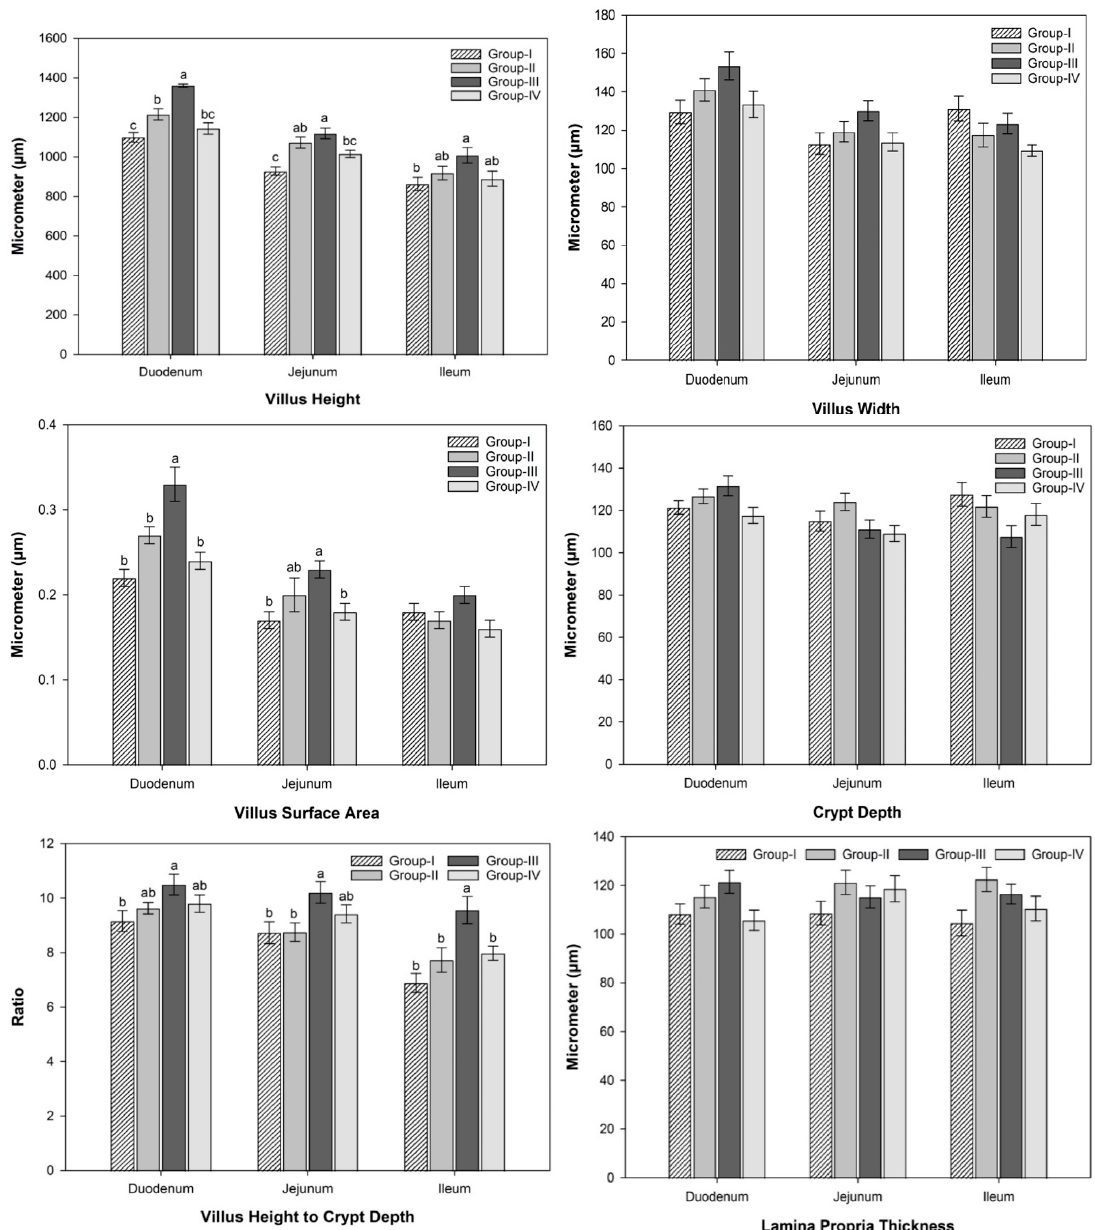
Figure 1. Graphical representation of the histomorphometric parameters of small intestine in broiler. Different superscripts ( a,b,c ) correspond to varying levels of significance between groups.